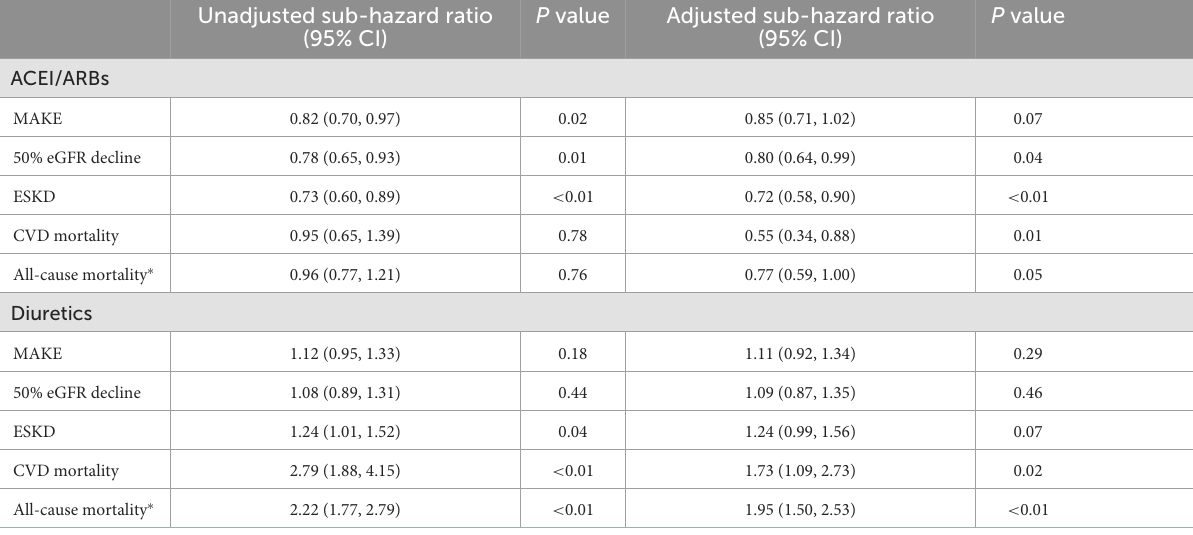
TABLE 4 Risk of adverse outcomes associated with the use of ACEI/ARBs and diuretics in the ICKD cohort. Unadjusted sub-hazard ratio (95%